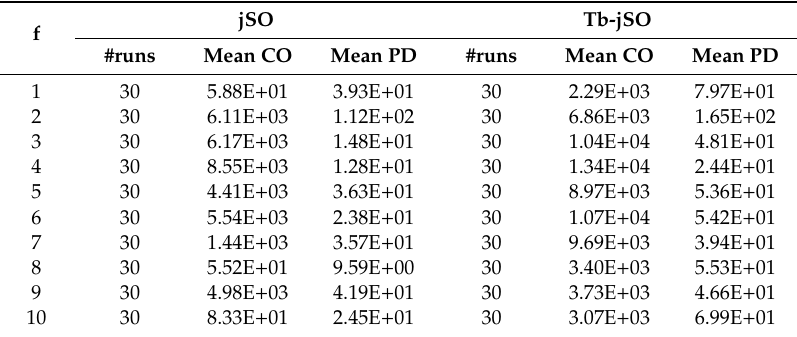
Table 32. Clustering and population diversity of jSO and Tb-jSO on the CEC2020 in 10 D .